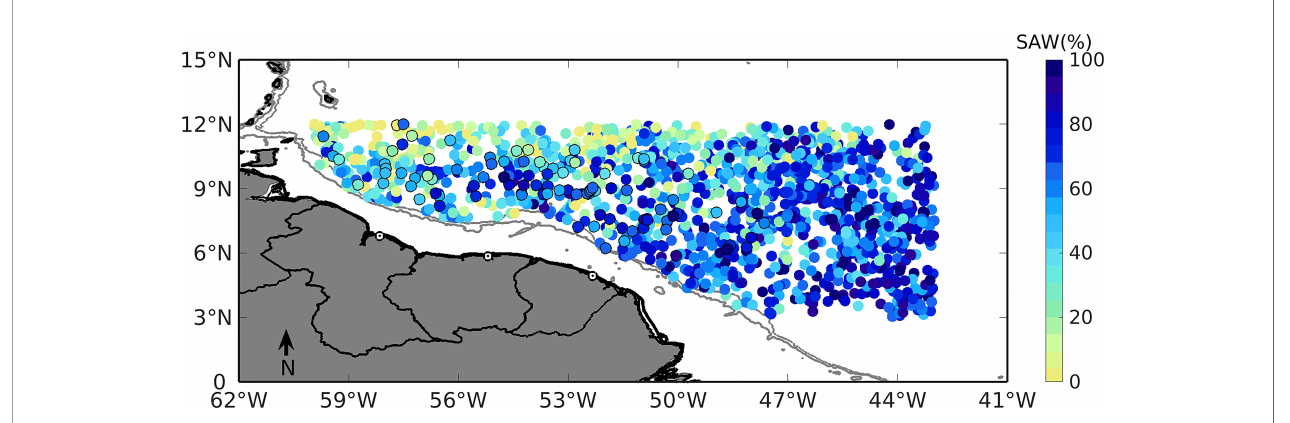
FIGURE 12 | Percentage of SAW for the s q = 25.5 kgm -3 density level, for all IR and OR pro fi les containing T/S pairs, within the sampling region. Each dot is one individual pro fi le, and dots with highlighted perimeter represent the IR pro